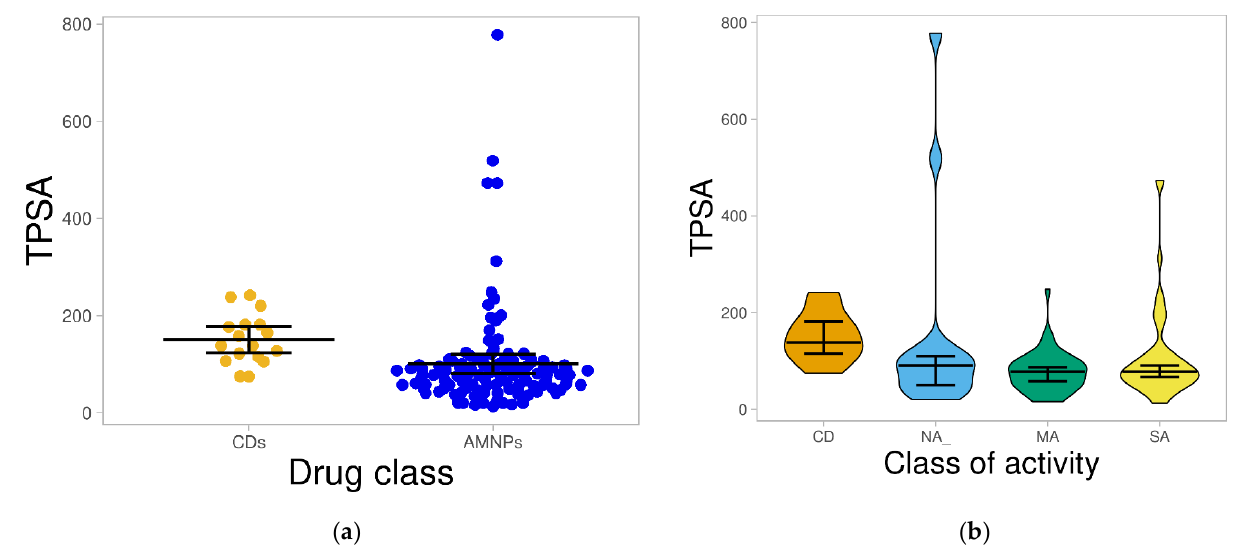
Figure 5. Distribution of TPSA for the datasets. ( a ) shows the distribution of TPSA for AMNPs compared with that for CDs; the average value for AMNPs was considerably lower ( p < 0.05) than that for CDs. ( b ) shows the distribution of the various categories of AMNPs compared with that of CDs. The boxes indicate the distribution of each dataset; the line that divides the boxes shows the median of the distributions. The black bars in both figures indicate a 95% confidence interval.